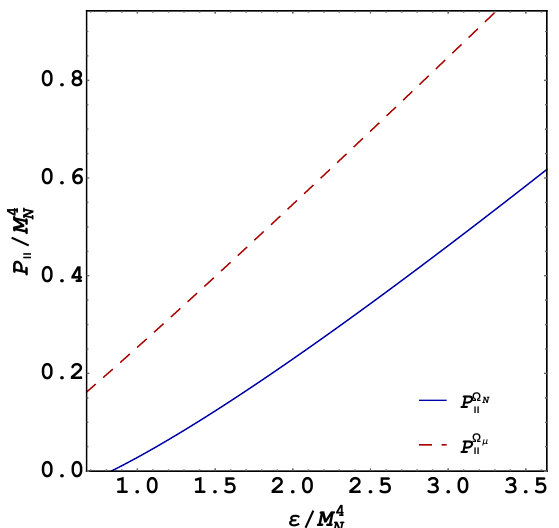
Figure 2. (Color online) Equations of state for the parallel pressure versus energy density. With Ω QFT contribution (continuous line) and without (dashed line). The magnetic field under consideration is B = 10 16